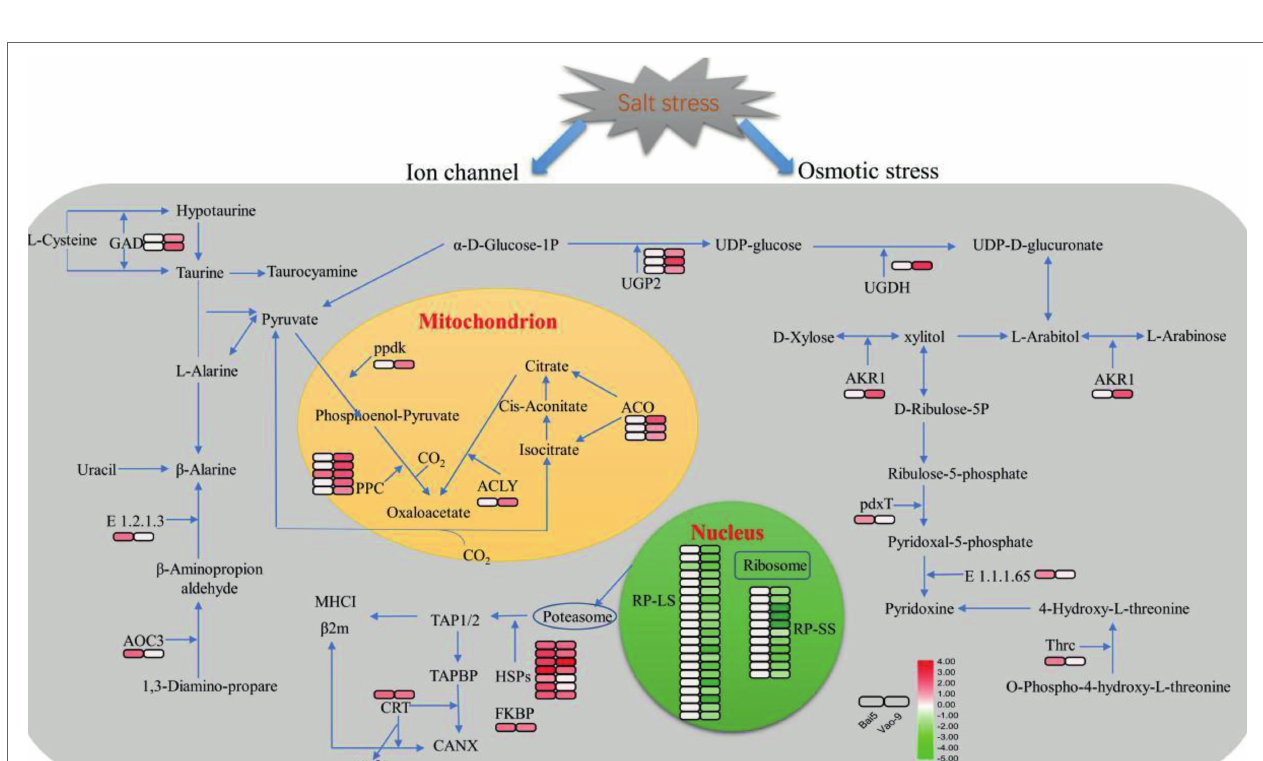
FIGURE 5 | Schematic presentation of the critical salt stress responsive proteins in oats. The fold change of DEPs are indicated by color filled in the squars on the right (see color key). The left square represents the fold change in Bai5 and the right square represents the fold change in Vao-9. The particular definition and fold change of proteins are in Table 4